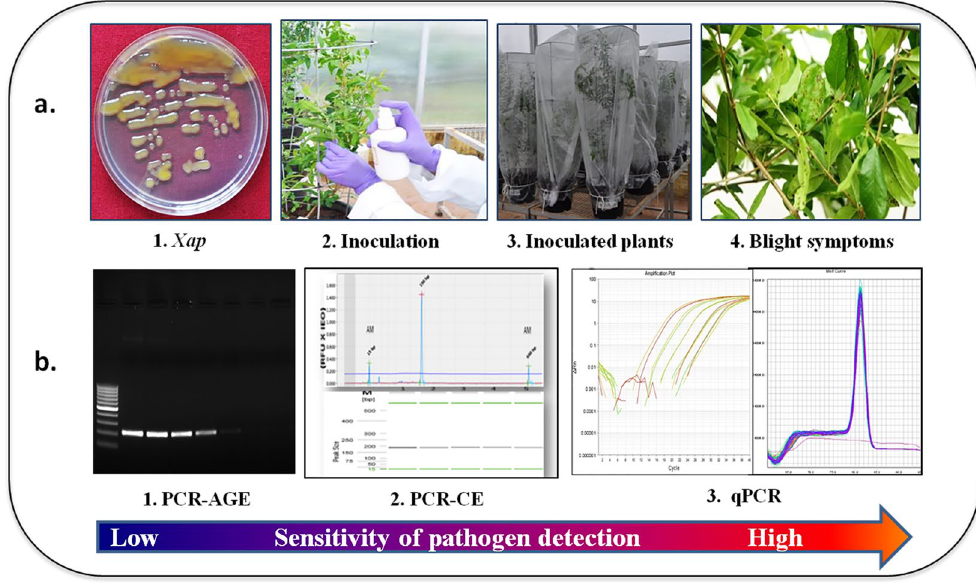
Figure 5. Overview of testing bacterial blight diagnosis in pomegranate by molecular techniques. ( a ) Pathogen challenge inoculation under greenhouse conditions. ( b ) Disease diagnosis by PCR, Capillary Electrophoresis, and